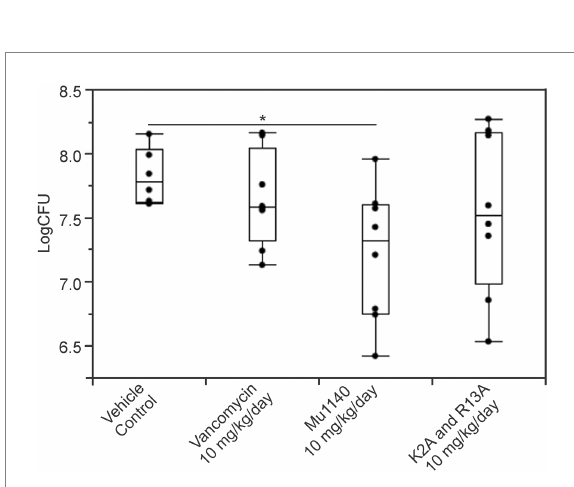
FIGURE 4 Bacteria load on the lesions of mice treated with vancomycin and mutacins via tail vein injection in a subcutaneous MRSA infection. All treatments including vehicle control were given to the animals 48 h post-infection and lasted for 5 days. Significance (*) was observed for the Mu1140 treatment group to the vehicle control group (mean difference = 0.61, Student’s t -test, Cohen’s d = 1.27, value of p = 0.0265; n = 6 for the vehicle control group, n = 8 for the other three groups, all groups contained equal numbers of male and female mice).